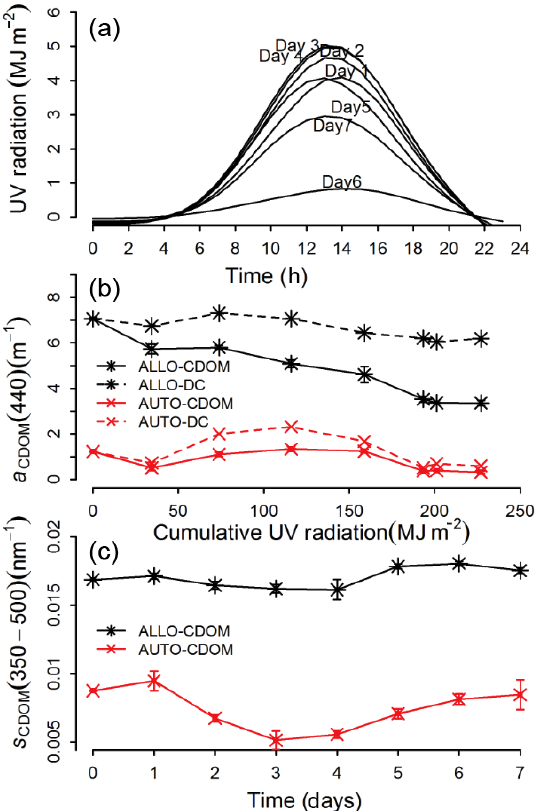
Figure 9. (a) Ultraviolet irradiance during the photobleaching ex- periment. (b) Variation of S CDOM (350–500) per day. (c) Variation of a CDOM (400) accumulated UV radiation.